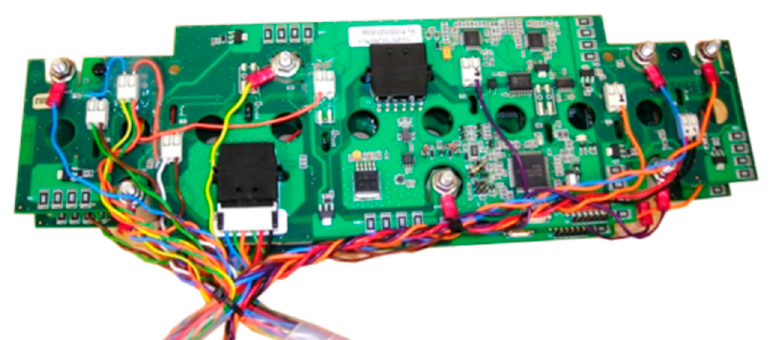
Figure 3. BMS with external measures.